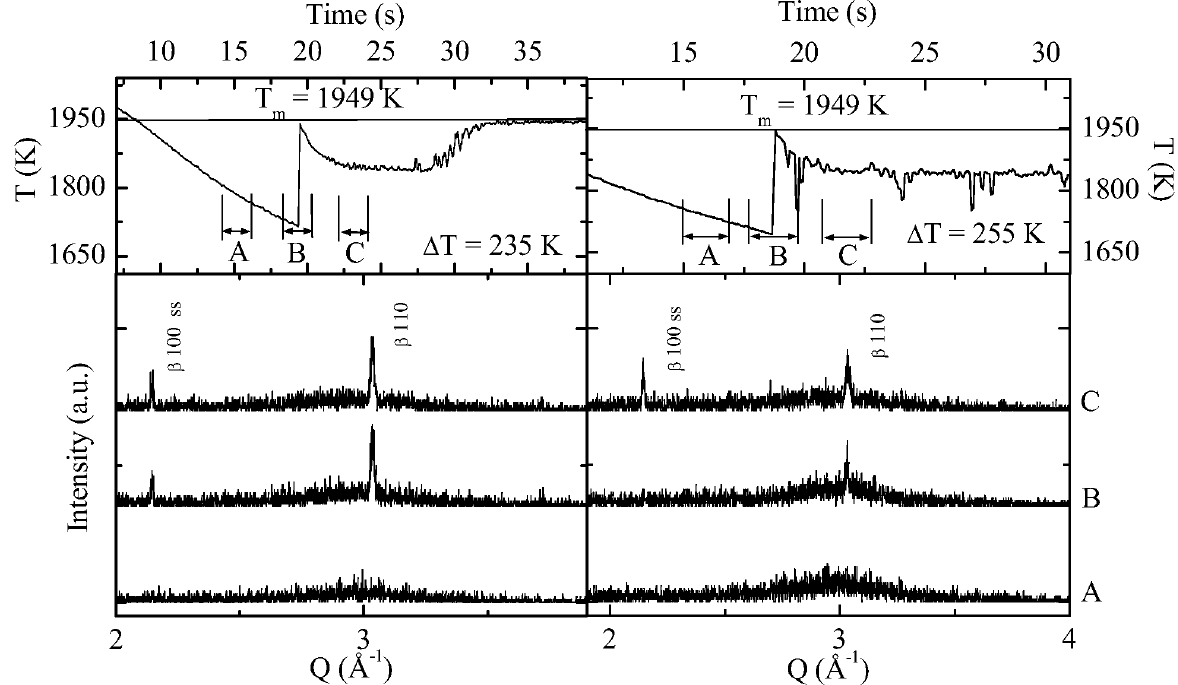
Figure 13. Temperature-time profiles (upper part) and EDXD spectra (lower part) measured during solidification of a Ni Al melt at an undercooling of ∆ T = 235 K ( left ) 50 50 and ∆T = 255 K ( right ). The arrows in the temperature-time profiles indicate the time intervals during which the X-ray diffractograms A, B, C were acquired. Note that the Bragg peak indexed by β (1,0,0), which corresponds to the superlattice structure of ordered B2 phase is missing on trace B on the right hand